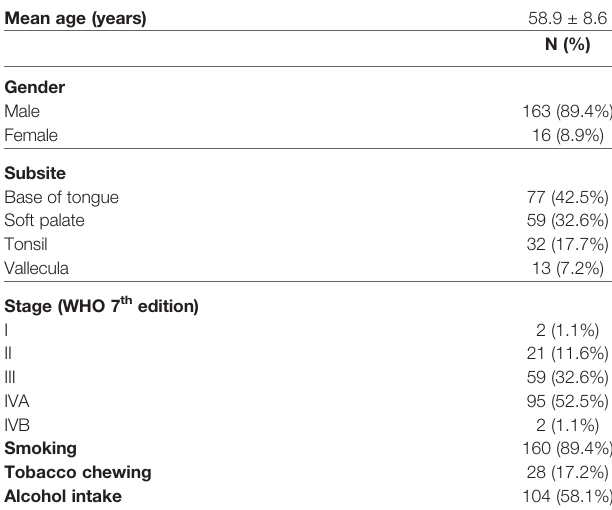
TABLE 1 | Patient and disease